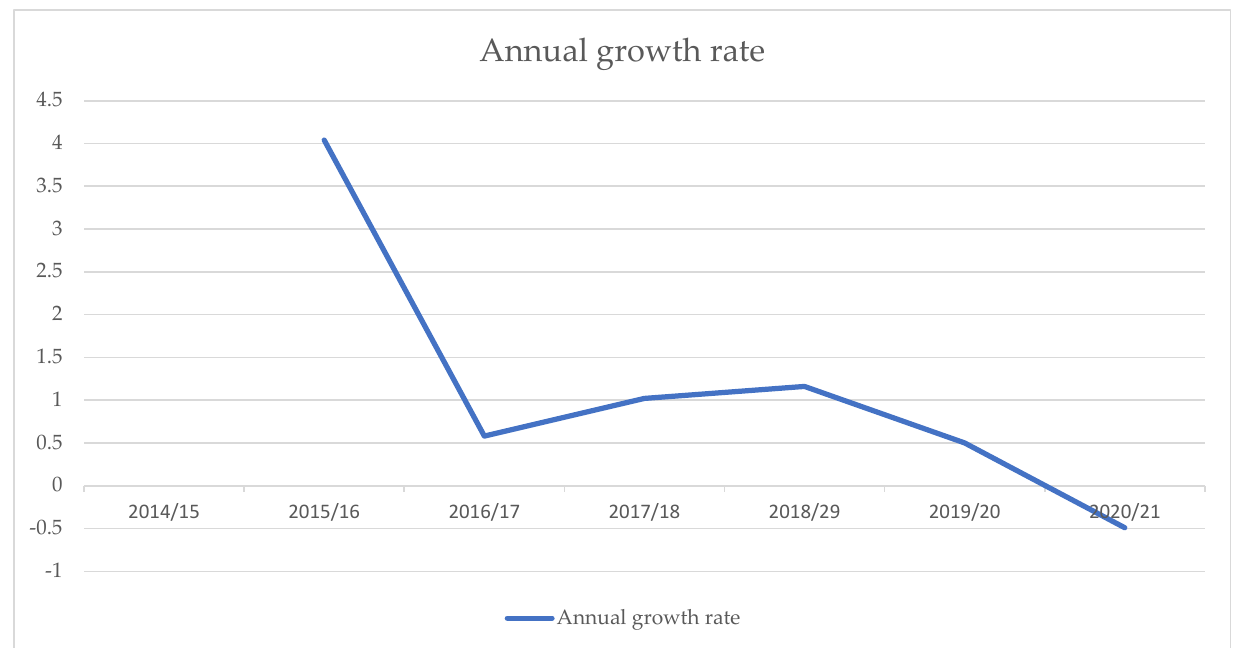
Figure 6. The export amount of IPDC-owned IPs (2014/15–2020/21); Source: IPDC, computed by